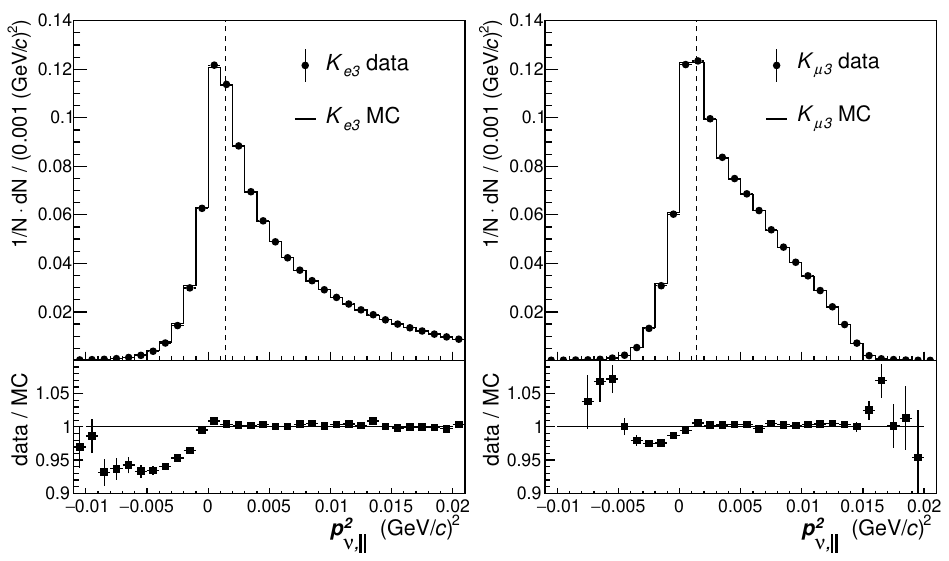
Figure 4 . Normalized p 2 distributions of data and MC simulated samples for K (cid:6) (cid:23); k K (cid:6) (right) modes and corresponding Data/MC ratios. The simulated samples include signal and (cid:22) 3 backgrounds. The vertical dashed lines indicate the p 2 > 0 : 0014 (GeV = c ) 2 cut (cid:23); k